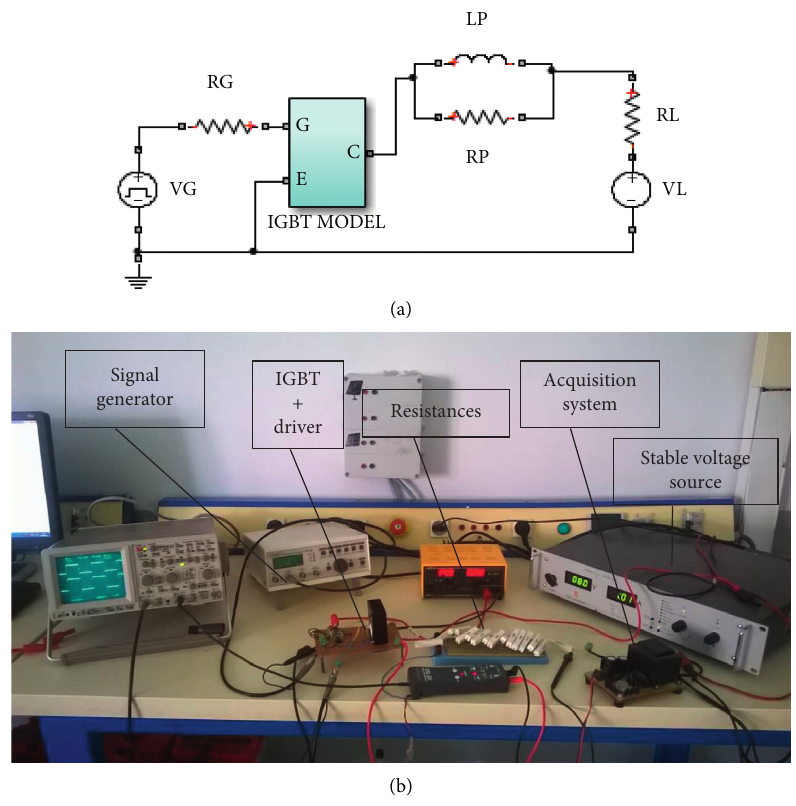
Figure 10: (a) Simulated circuit. (b) Photography of the IGBT test bench.